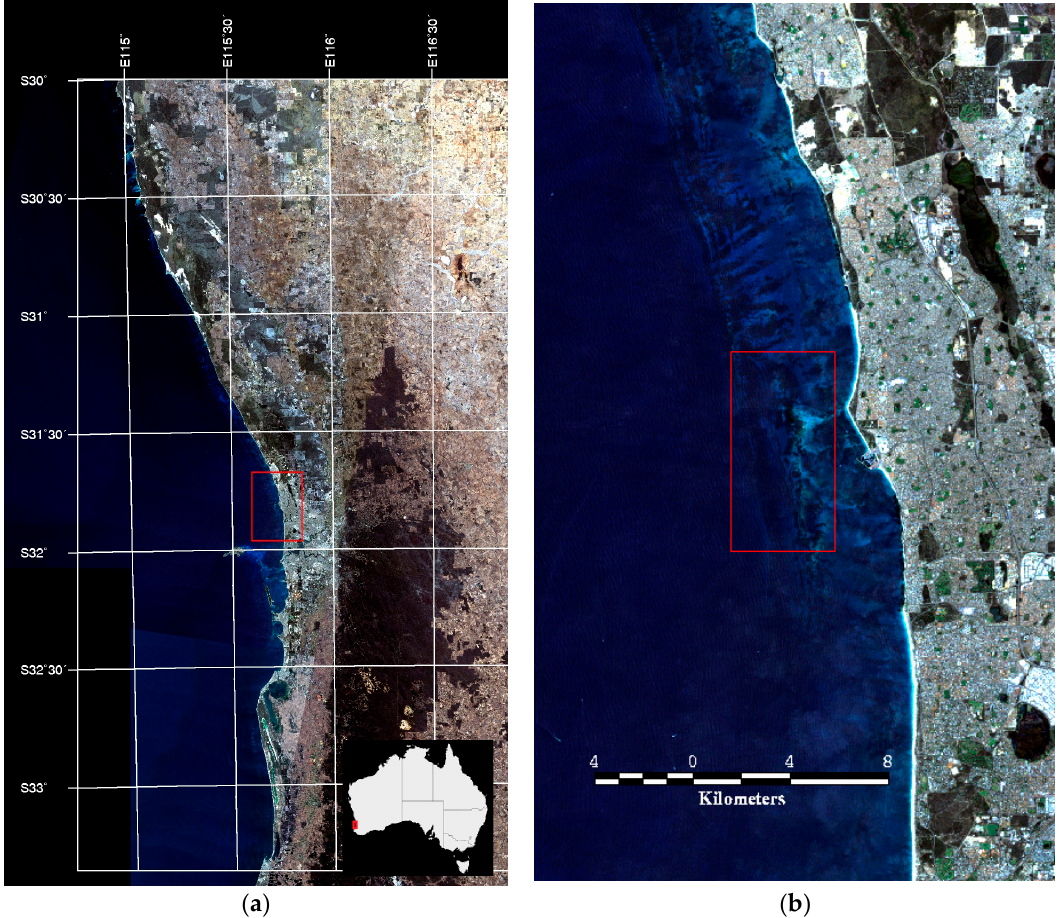
Figure 1. ( a ) An overview of the study area, with inset showing location in Australia. The city of Perth, Western Australia is in the centre. The red rectangle shows the extents of the image in ( b ), which shows Hillarys Marina in the centre; Marmion Marine Park is to the left. The red rectangle shows the study area.